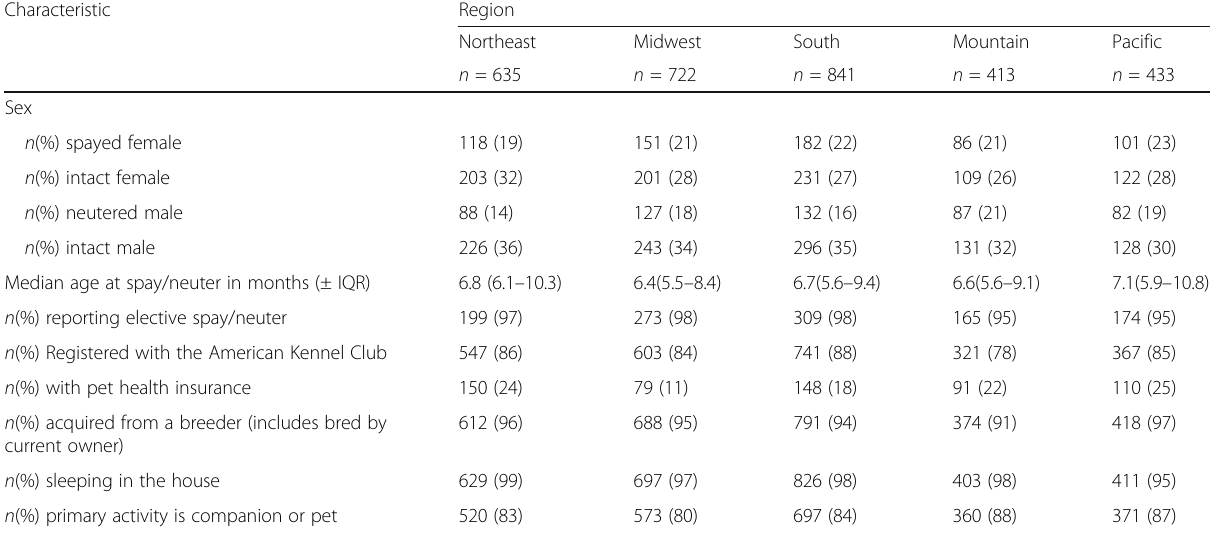
Table 1 Descriptive characteristics of 3044 Golden Retriever Dogs participating in the Golden Retriever Lifetime Study at their